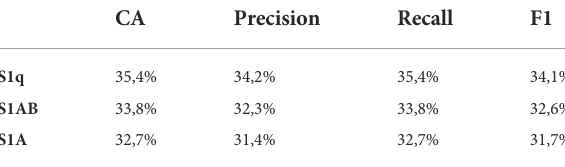
TABLE 4 Accuracy metrics of the random forest classi fi cation. CA